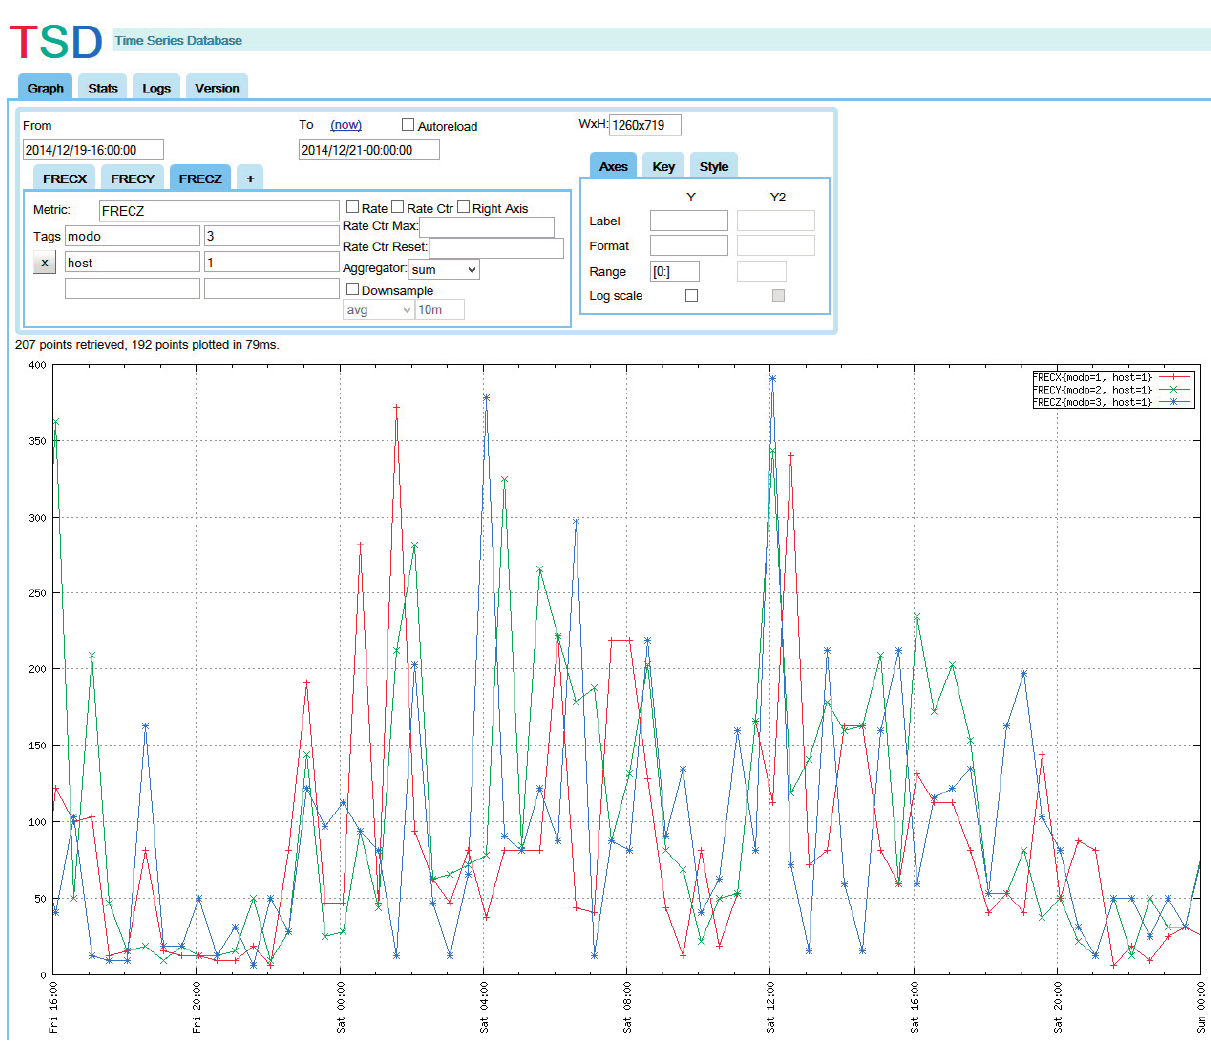
Figure 19. OpenTSDB screenshot with data from the